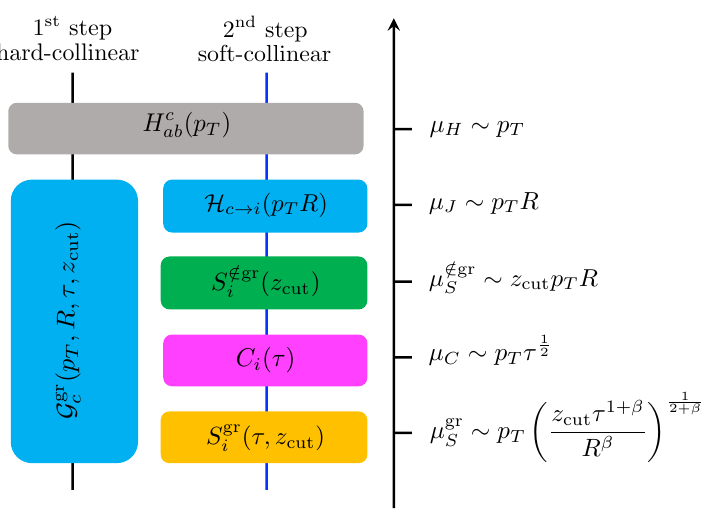
Figure 3 . Illustration of the two-step factorization procedure for the jet mass distribution in the presence of soft drop grooming. The (cid:12)rst step is a hard collinear factorization of the groomed gr siJMFs from the hard functions H c c G terms of hard matching functions and S gr . Here S = 2 gr i